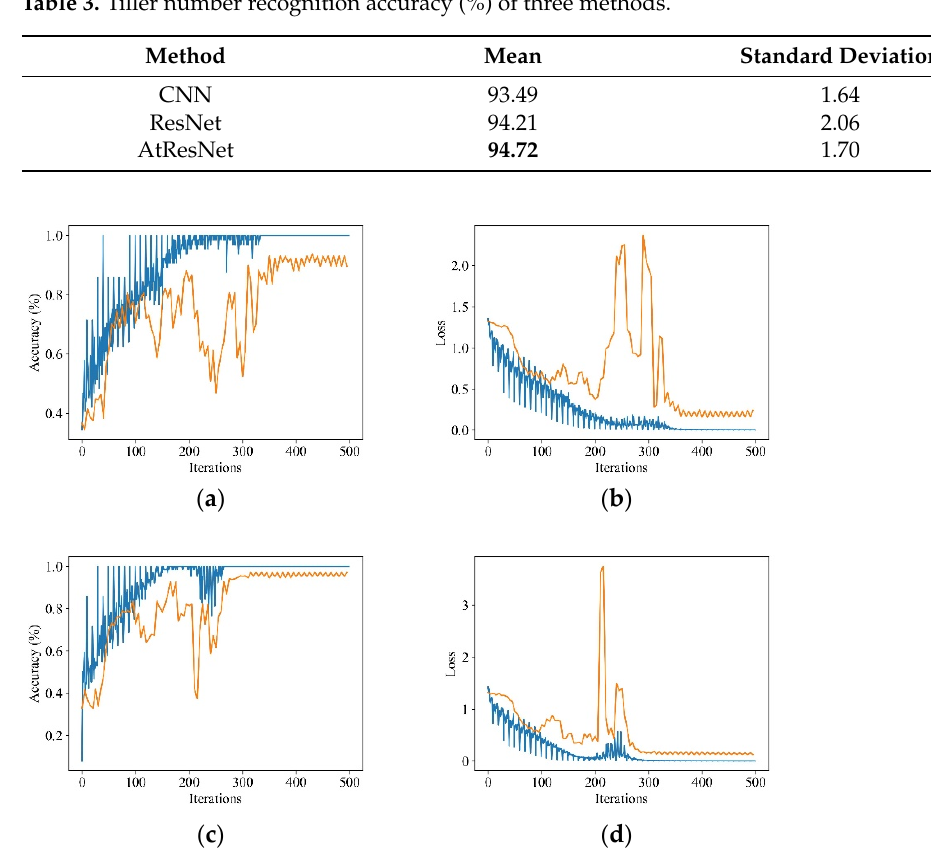
Figure 7. Training and testing accuracy and loss value curve. ( a ) CNN accuracy. ( b ) CNN loss. ( c ) AtResNet accuracy. ( d ) AtResNet loss. Blue line denotes training process and orange line denotes testing process.